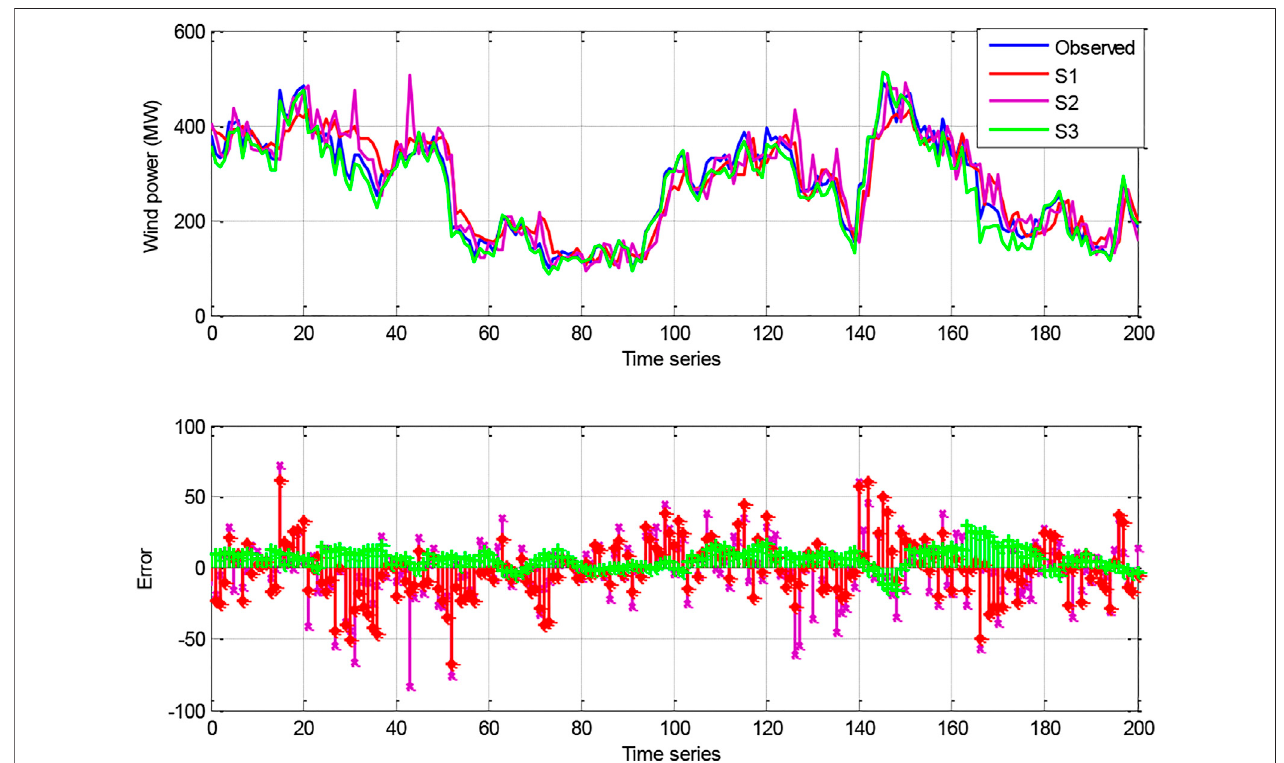
FIGURE 1 | Wind power prediction based on three given chaotic time series models.